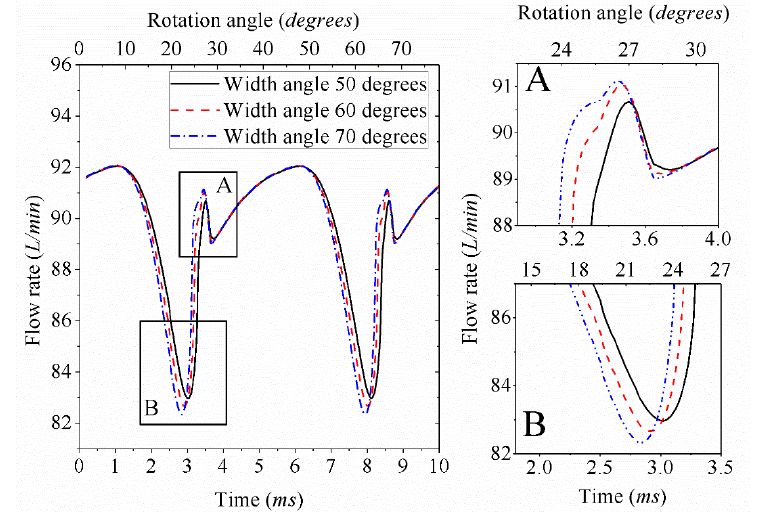
Figure 8. Effects on discharge flow rate with different width angles. Figure 8. E ff ects on discharge flow rate with di ff erent width